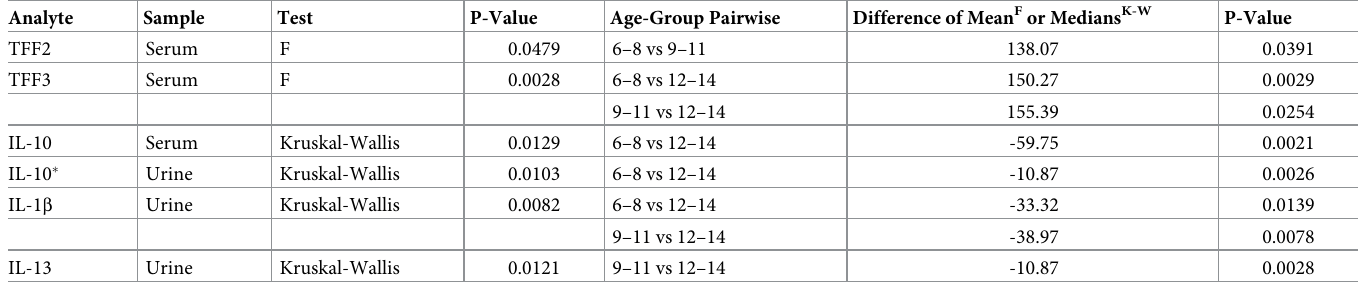
Table 5. Analytes and sample type with significant infection effect where age-effects were also observed in Nigerian children.